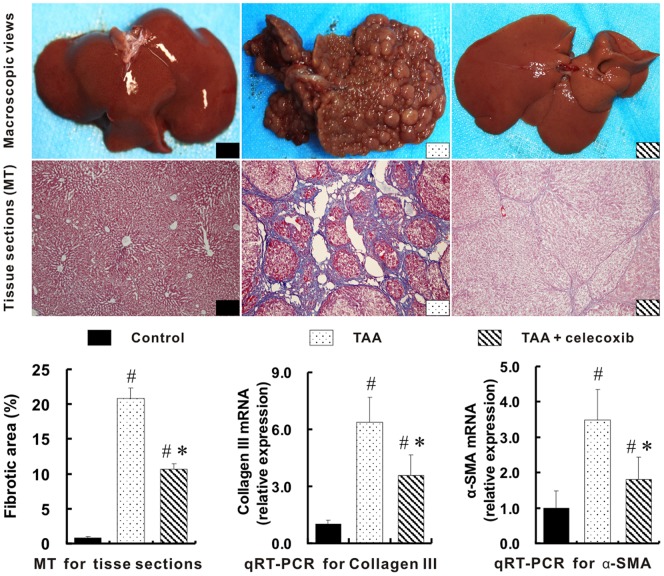
Reduction of hepatic fibrosis with celecoxib treatment.Compared with the livers in control group, a typical cirrhotic appearance with extensive nodular formation (middle of upper panel) was presented in the livers of TAA group. These hepatic nodules in TAA+celecoxib group were almost not observed by macroscopic view and were greatly reduced in the tissue sections (x100 magnifications) stained with MT. The percentages of fibrotic areas and expression of collagen III and α-SMA are plotted on the bottom. # p<0.01 vs. control group; * p<0.01 vs. TAA group.